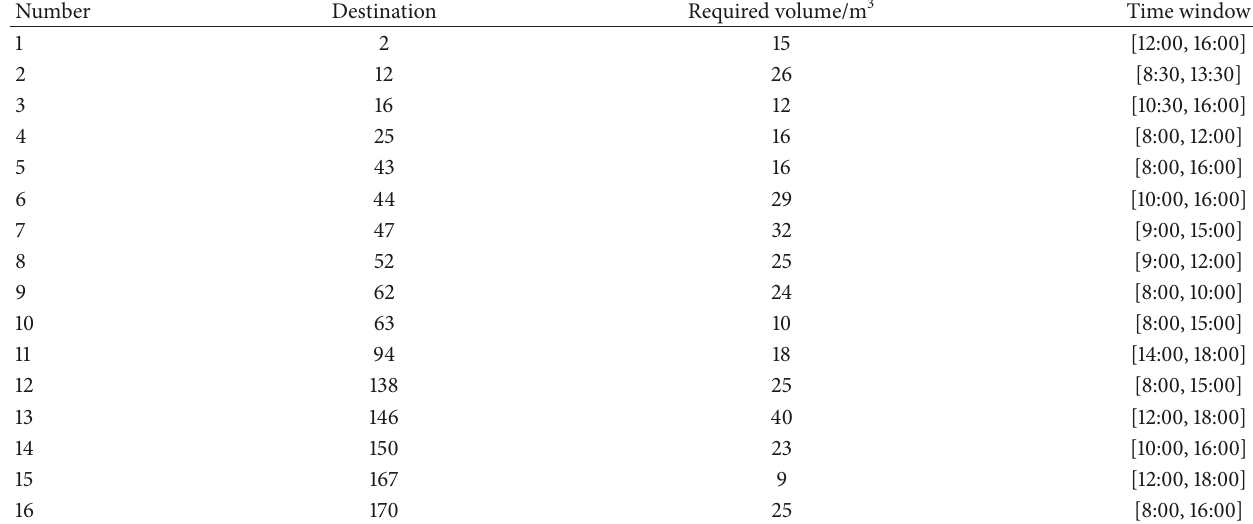
Table 7: Nodes representing 16 gas stations, as well as their needs of gasoline, and the time window of distribution.